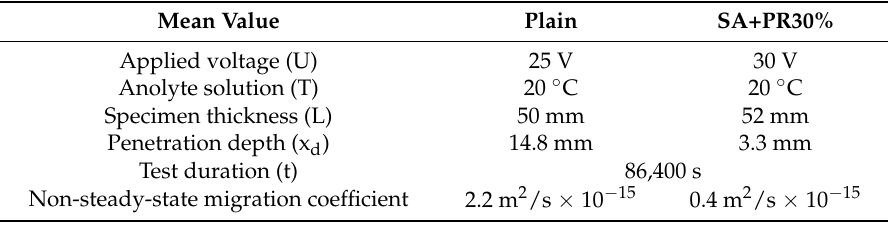
Figure 6. Weight loss of specimens.